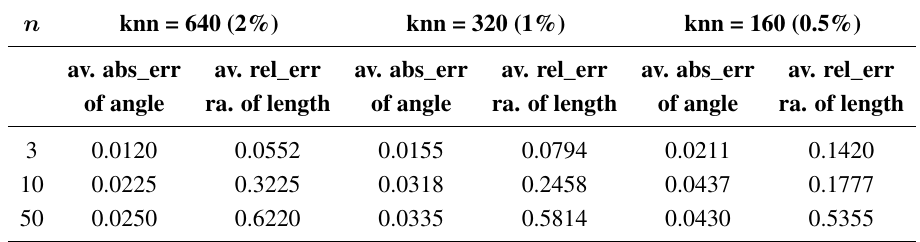
Table 7. The results of (cid:96) MCDA on four superimposed Student t distributions. 1